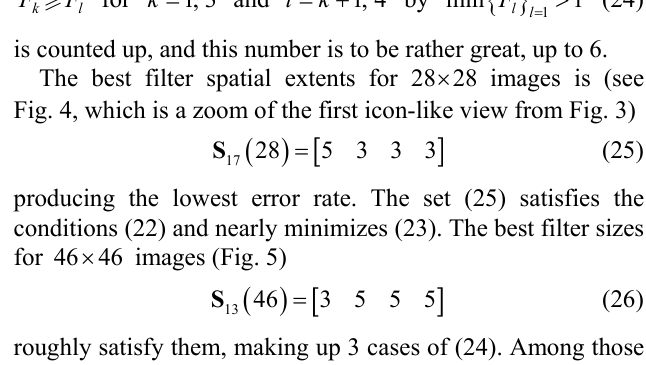
28 V along 128 epochs (the “worst” effect is 53